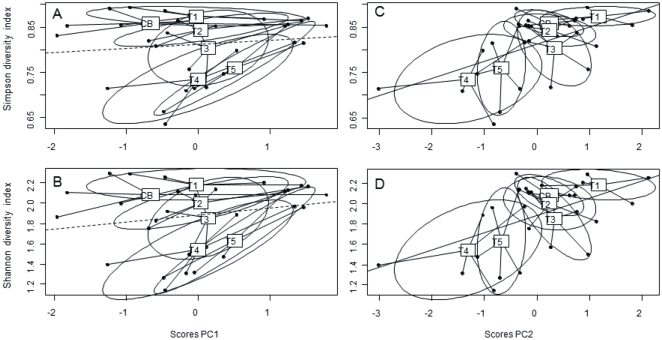
Linear regressions between bacterial diversity indexes and PC1 and PC2 scores of the Principal Component Analysis.Each treatment is represented by its ellipse inertia and its gravity centre (CB: control, T1–5: increasing triclosan concentration). Solid line: significant linear regressions, dashed lines: non-significant linear regressions.